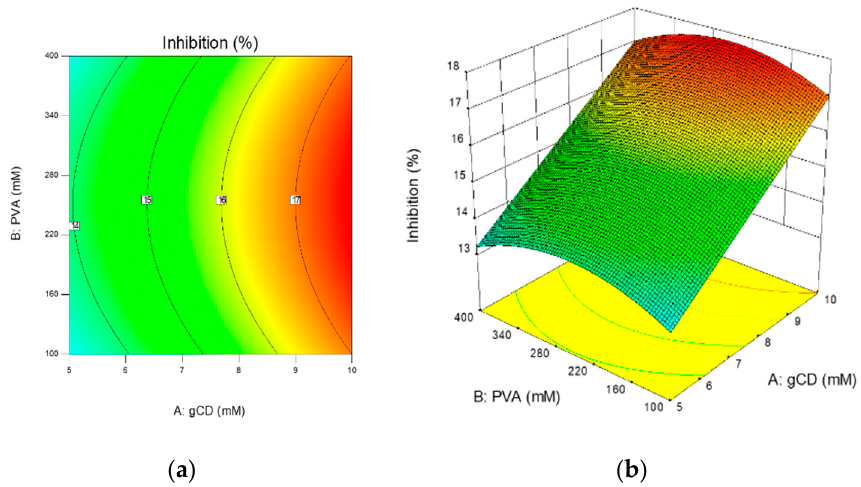
Figure 7. Contour ( a ) and surface ( b ) plots demonstrating relationship between γ CD and PVA concentrations on percentage of inhibition.